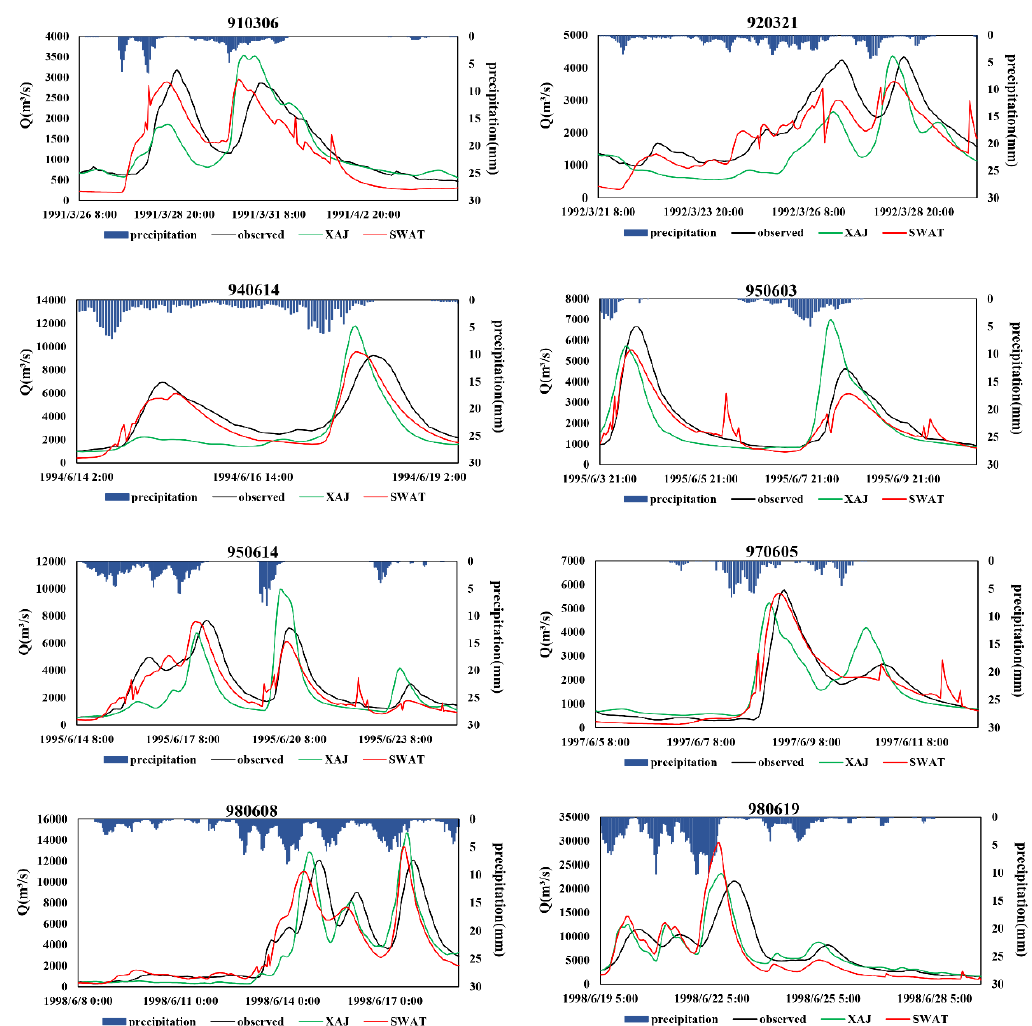
Figure 5. Comparison of simulation of floods conducted using XAJ and SWAT models.